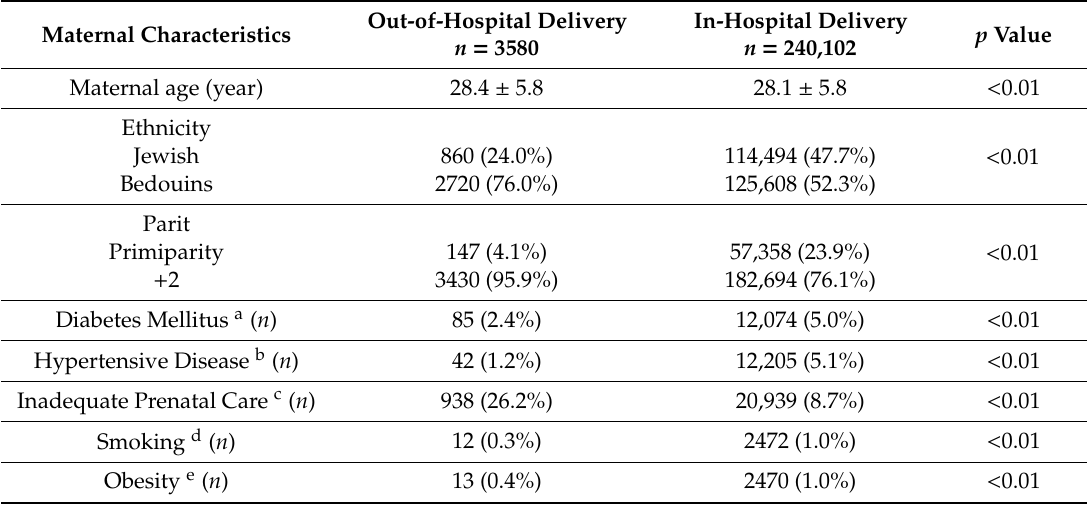
Table 1. Maternal characteristics of mothers with unplanned out-of-hospital delivery compared to in-hospital